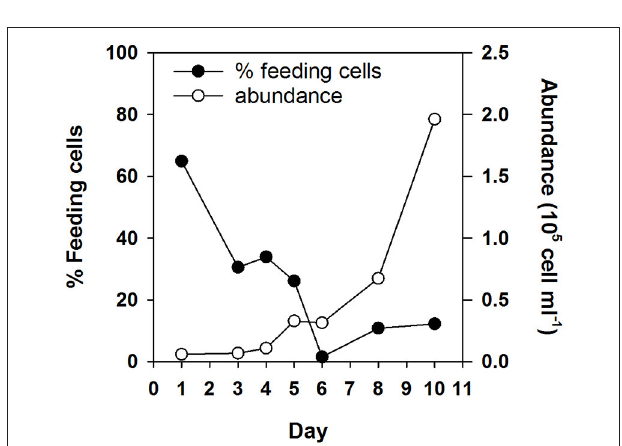
FIGURE 3 | Change in phytoflagellate abundance and percentage of feeding cells over time for a starved N. pyriformis culture after being re-inoculated into nutrient replete media.